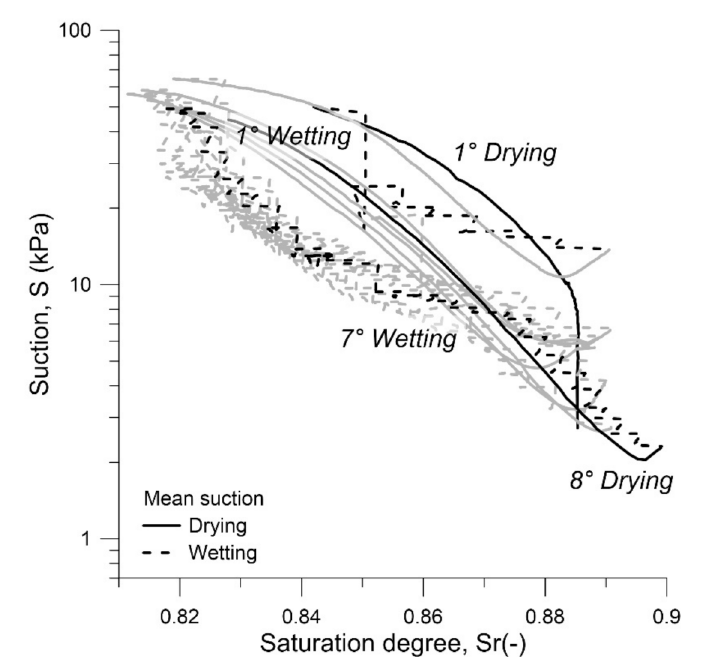
Figure 6. Suction measurements during drying–wetting cycles in Hyprop on a sample of the dyke silty material as a function of the average degree of saturation of the